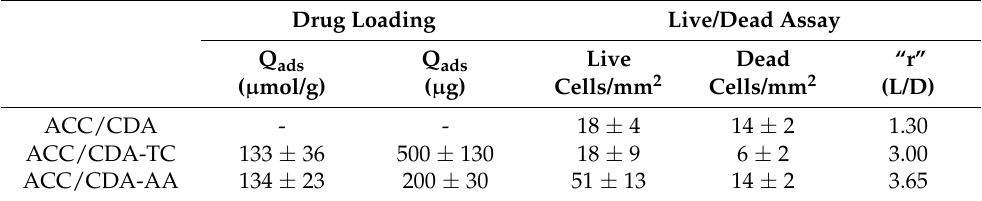
Figure 8. Tetracycline and aspirin estimated release from ACC substrate. Table 5. Live or dead osteoblast cell number calculated using fluorescence microscopy images after coloration by live/dead kit. Quantification of cell number by mm 2 on the materials after 2 days of culture was performed using the ImageJ software. Mean ± standard